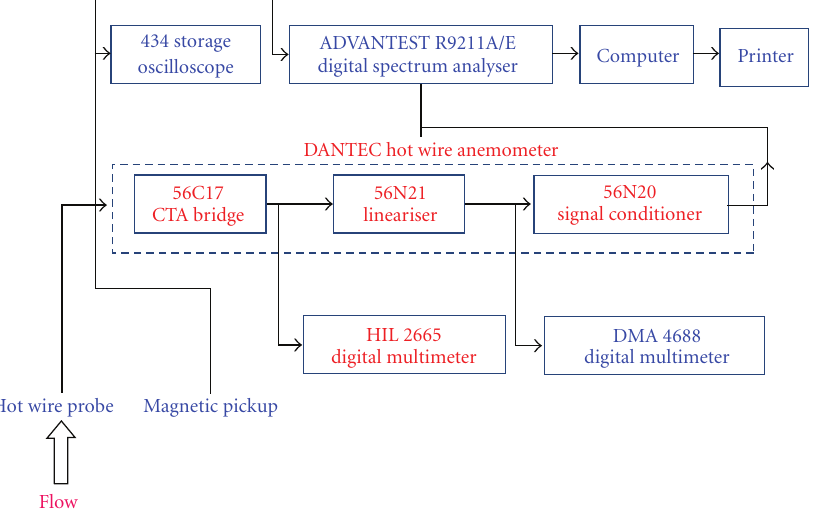
Figure 4: Schematic of instrumentation for hot wire probe measurements.